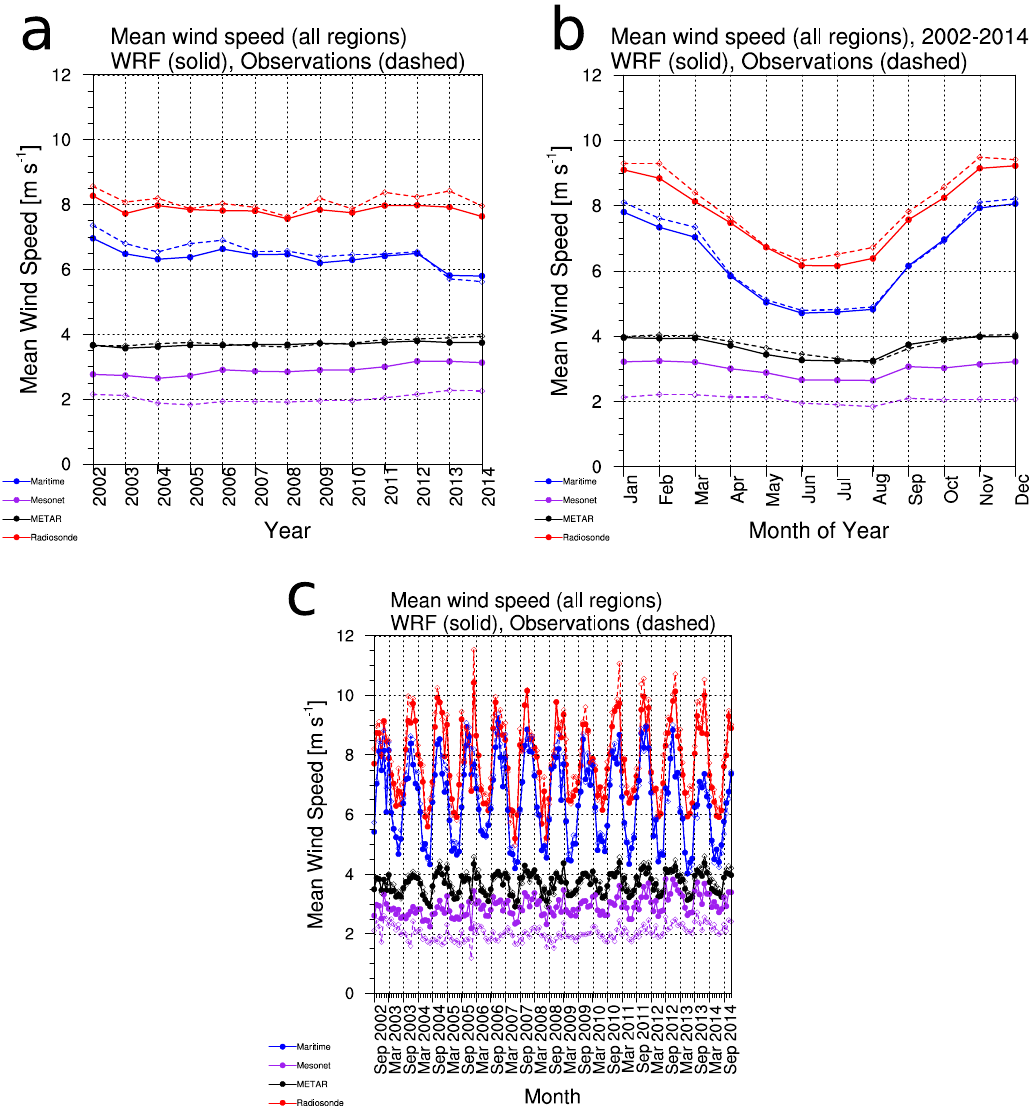
Figure 9. Mean wind speed across all regions for WRF (solid lines) and observations (dashed lines), for maritime (blue lines), mesonet (purple lines), METAR (black lines), and radiosonde (red lines) networks, averaged ( a ) by year, ( b ) by month of year, and ( c ) by month.